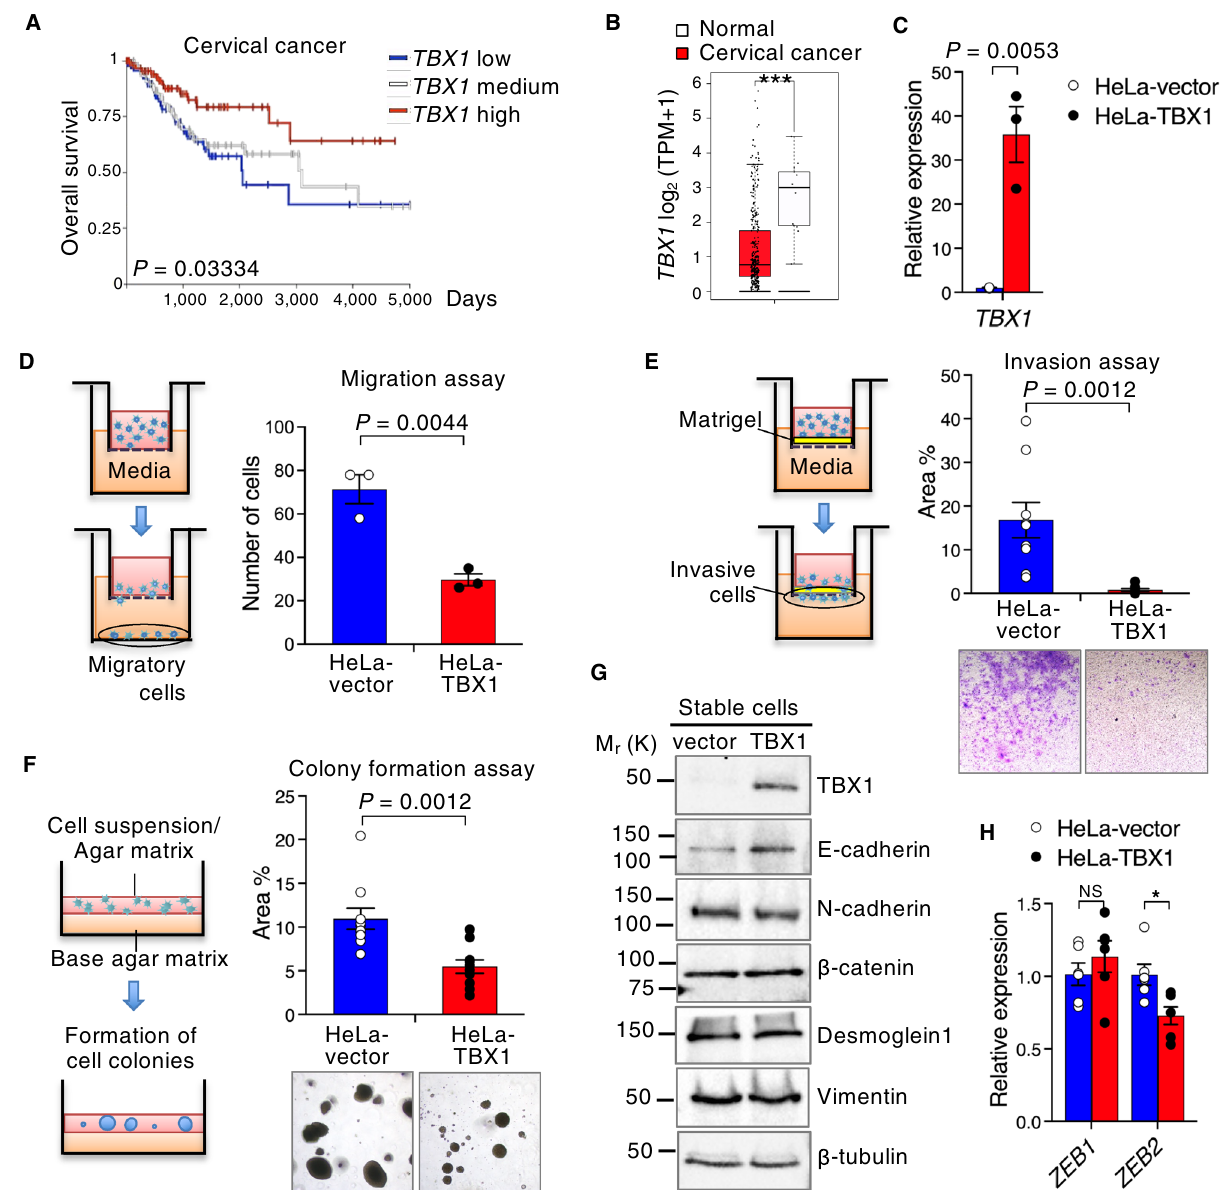
Figure 1. TBX1 inhibits cell migration, invasion, and soft agar colony formation. ( A ) Kaplan–Meier curve representing overall survival in patients with primary cervical cancer ( n = 288) with high, medium, or low TBX1 expression. Two-sided P- values were computed using a log-rank (Mantel-Cox) test. ( B ) Box plots were obtained from the GEPIA using the GTEx database to compare the expression of TBX1 in cervical cancer ( n = 306) and matched normal specimens ( n = 13). TPM, transcripts per million. *** P ≤ 0.001; one-way ANOVA. ( C ) Expression of TBX1 was examined by qPCR in HeLa cells stably transfected with control pEBMulti plasmid (vector) or pEBMulti-TBX1 plasmid (TBX1). n = 6. ( D ) Comparison of the relative migration of HeLa cells stably transfected with empty vector (HeLa-vector) or TBX1 (HeLa-TBX1) towards a 10% serum gradient for 24 h. n = 3. ( E ) In vitro invasion assays for HeLa cells stably transfected with empty vector or TBX1. Representative images of invaded cells are shown below the bar plot. n = 9. ( F ) Soft agar colony formation assays with HeLa cells stably transfected with the empty vector or TBX1. Colony-forming efficiency was determined after culturing for 3 weeks in the presence of hygromycin in three independent assays ( n = 10). Representative images of colonies are shown below the bar plot. ( G ) Western blot analysis of extracts derived from HeLa cells stably transfected with empty vector or TBX1 for EMT-related markers. The full-length blots are shown in Supplementary data, Fig. S13. ( H ) Expression of ZEB1 and ZEB2 was examined with qPCR in HeLa-vector or HeLa-TBX1 cells ( n = 6, * P ≤ 0.05; NS, not significant). For ( C-F ) and ( H ), the results are presented as mean ± s.e.m.; unpaired two-tailed Student’s t